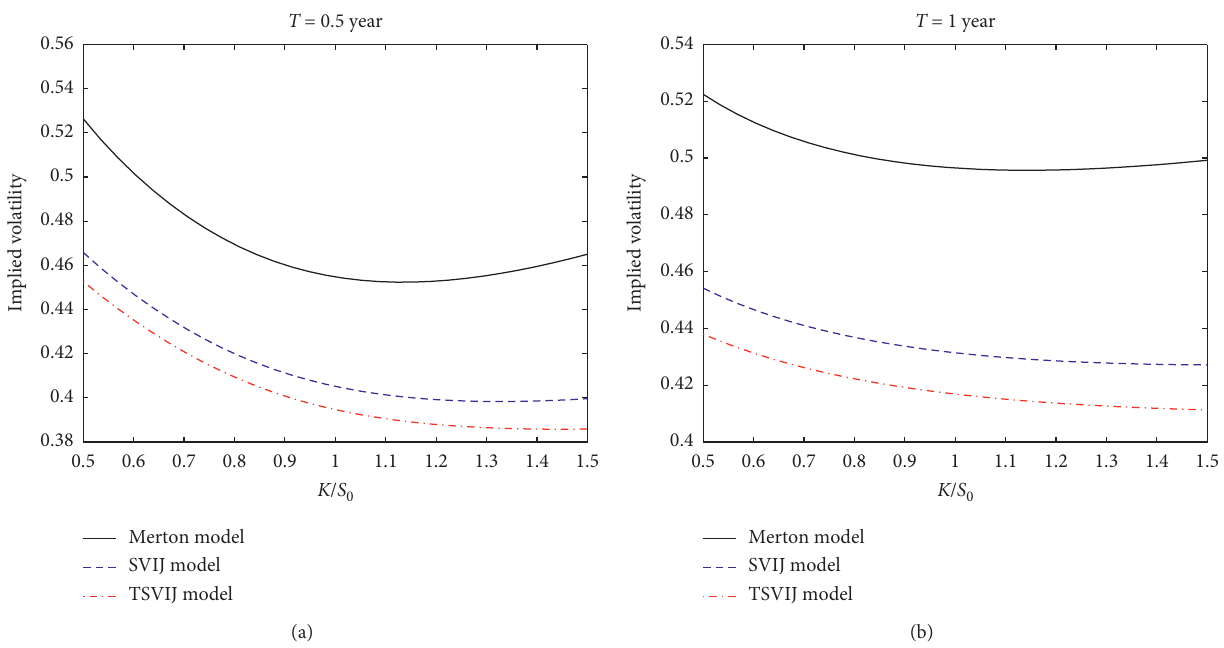
Figure 1: Implied volatility for three models with short and long